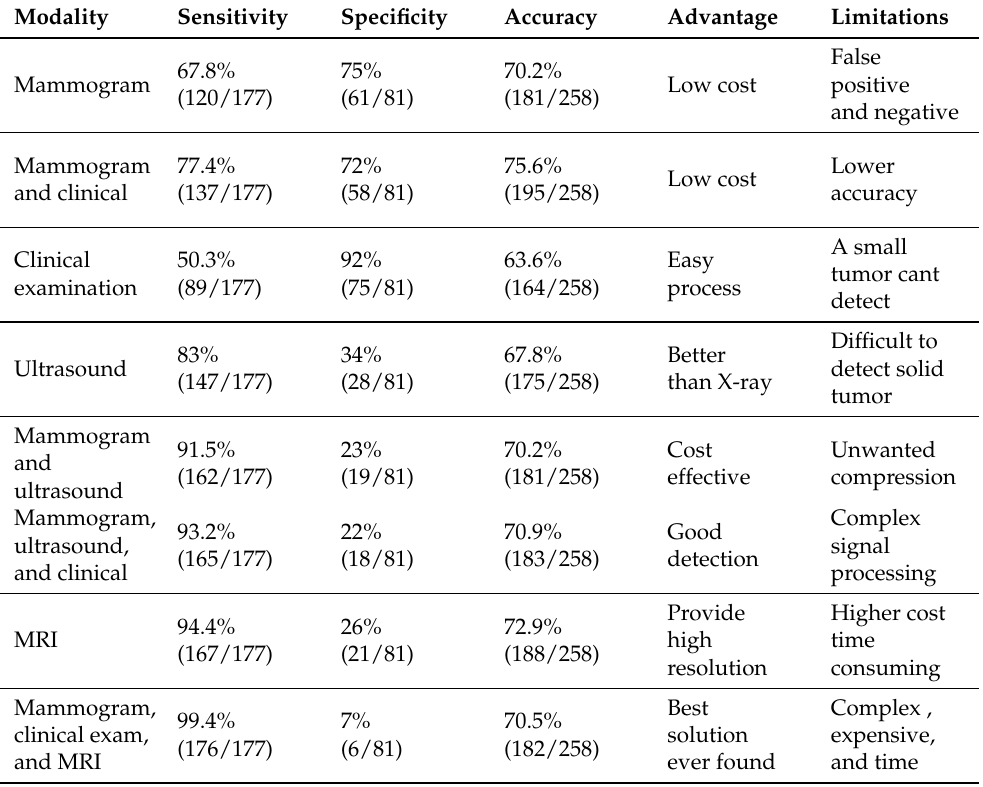
Table 4. Comparison of diagnostic performance of different breast tumor detection techniques